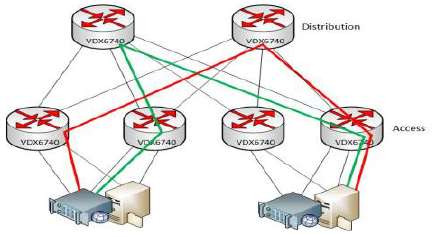
Fig. 2. Unblocked network architecture (two of the eight possible paths are shown).